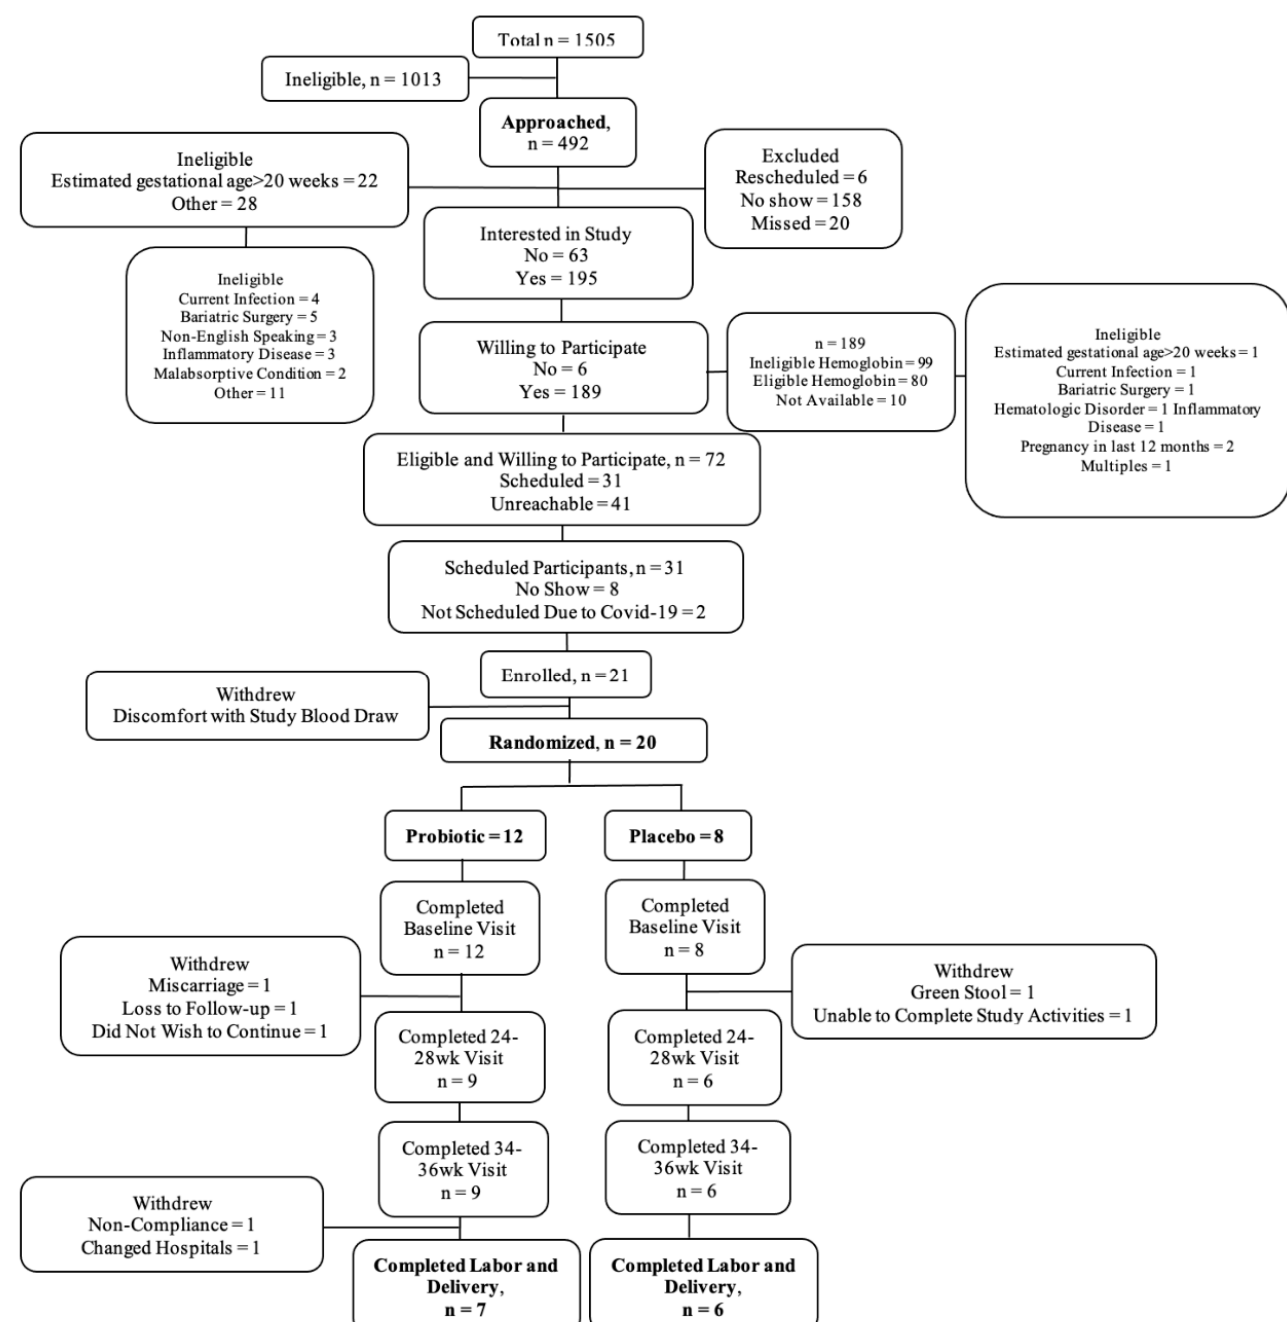
Figure 1. CONSORT flow diagram.